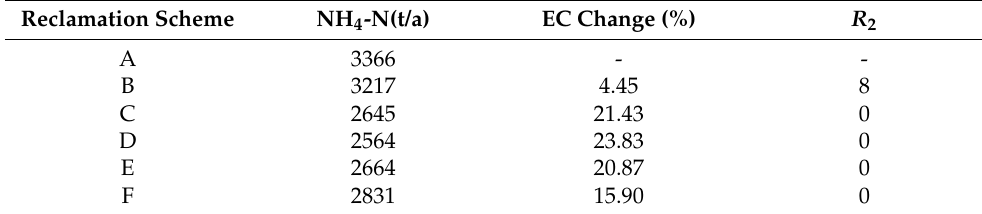
Table 6. Feasibility evaluation in NH 4 -N environmental